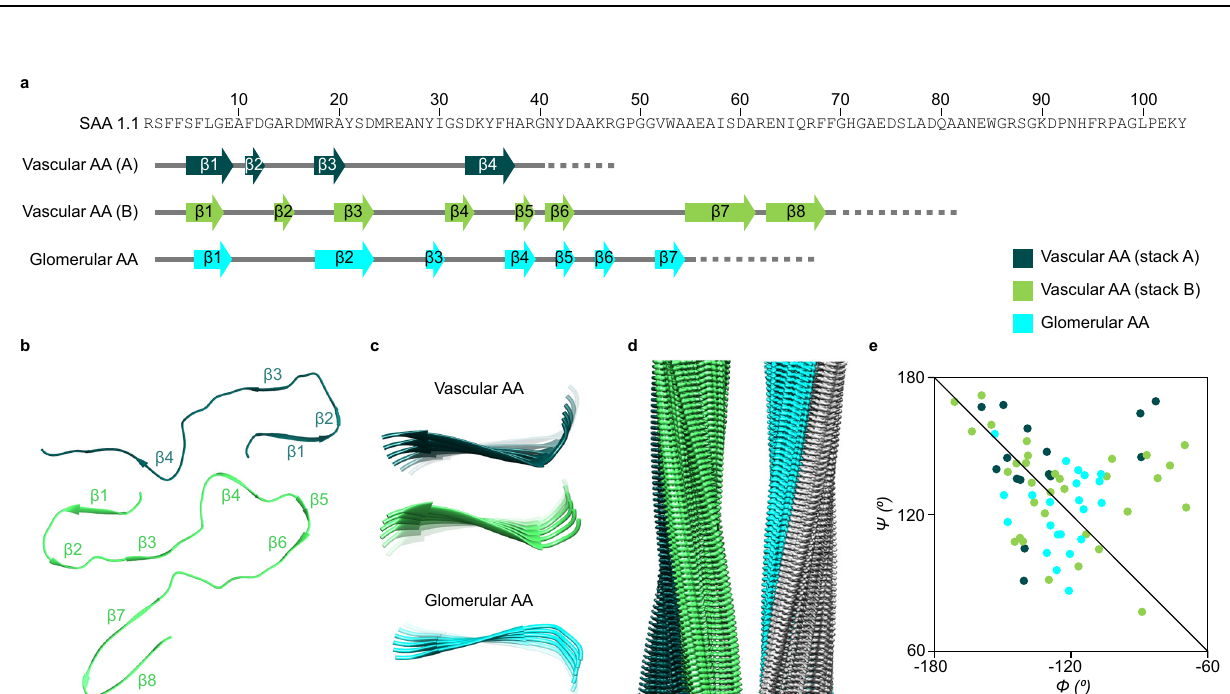
Fig.2|Cryo-EMstructureofthevascularAAamyloid fi bril.a Contrast-enhanced cryo-EM image of vascular AA amyloid fi brils from patient I. Scale bar: 10nm. The micrograph is representative of 1,957 cryo-EM micrographs. b Side views of the reconstructed3Dmap(left)andaribbondiagramoftheresultingmolecularmodel (right). c Superimposition of a cross-sectionalslice ofthe 3Dmapwithone layer of